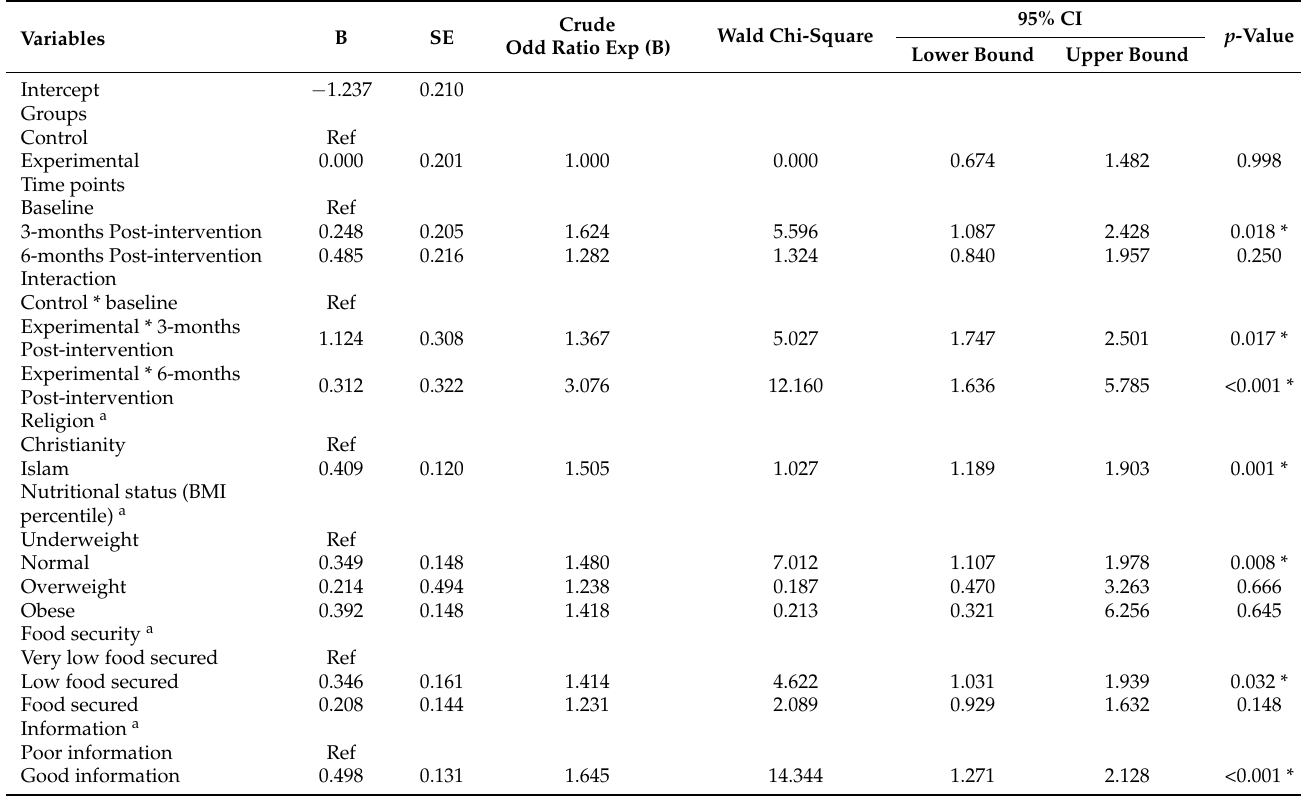
Table 7. Effectiveness of Triple Benefit Health Education Intervention on Attitude towards Malnu- trition between Groups and Time Points (baseline, three and six post-intervention) adjusted with Covariates using GEE.